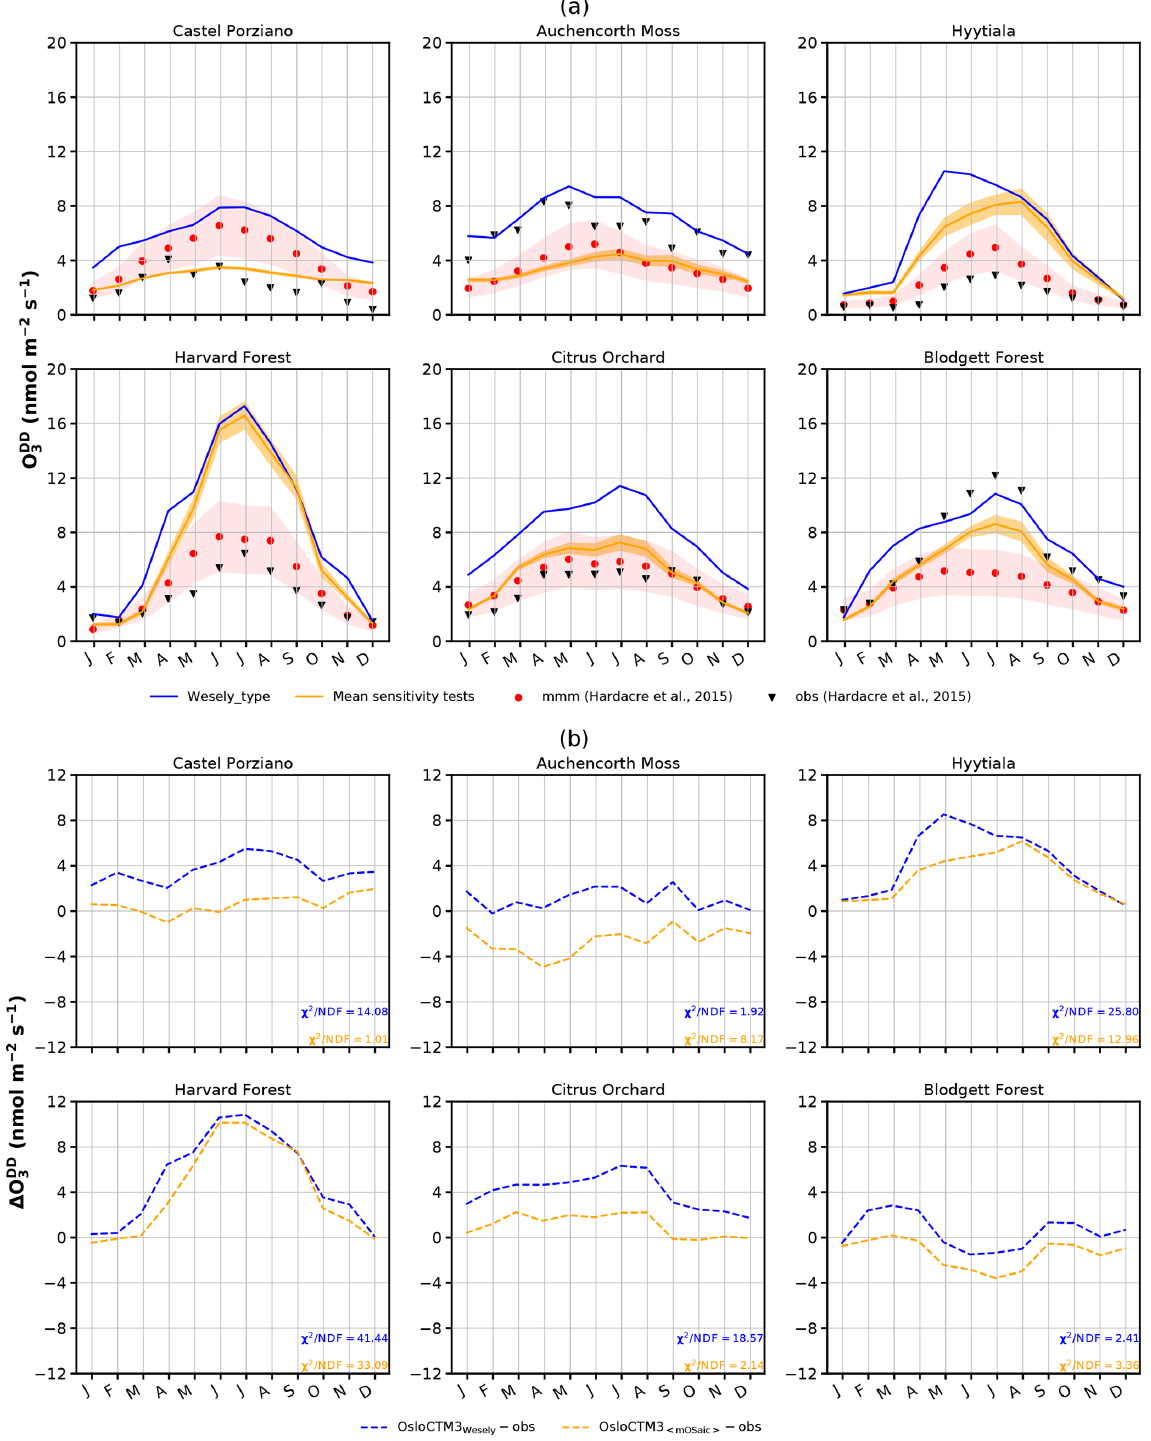
Figure 9. Ozone dry deposition fluxes at different observation sites. (a) Comparison between Wesely scheme and average result from all sensitivity studies with observational averages taken from Hardacre et al. (2015). The model uncertainty of Oslo CTM3 is given as a 1 σ error band. The shaded area around the multi-model mean indicates the broad range of different model results but is not an actual error band. (b) Model divergence from observation and χ 2 -test